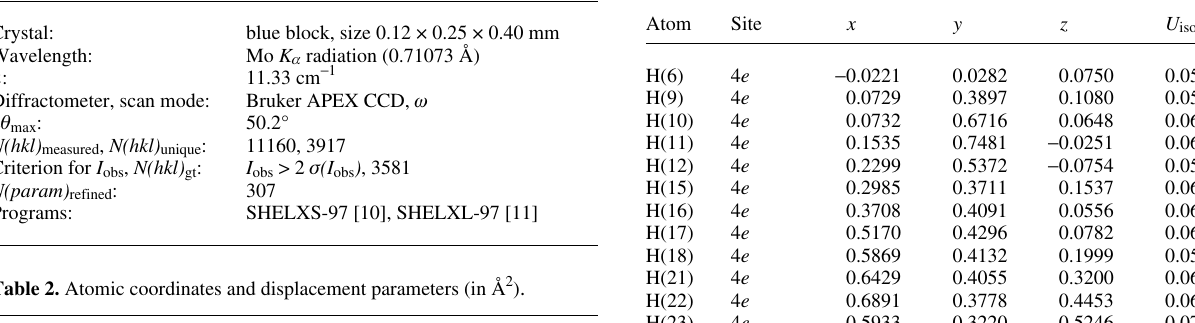
Table 1. Data collection and